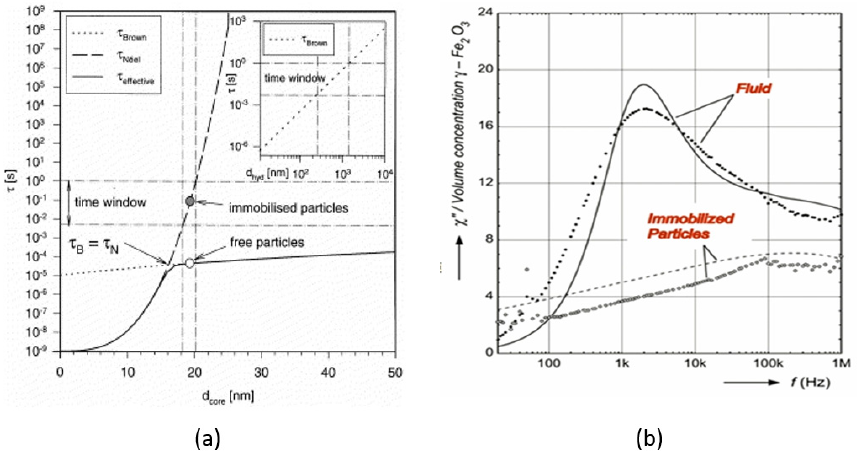
Figure 7. ( a ) Néel and Brown relaxation times calculated over a range of particle sizes for a water- based magnetite ferrofluid [96]; ( b ) Imaginary part of susceptibility of maghemite based aqueous suspension in comparison to the identical particles immobilized in the gel. Reprinted with permission [96,98]. Copyright 2021, Elsevier.